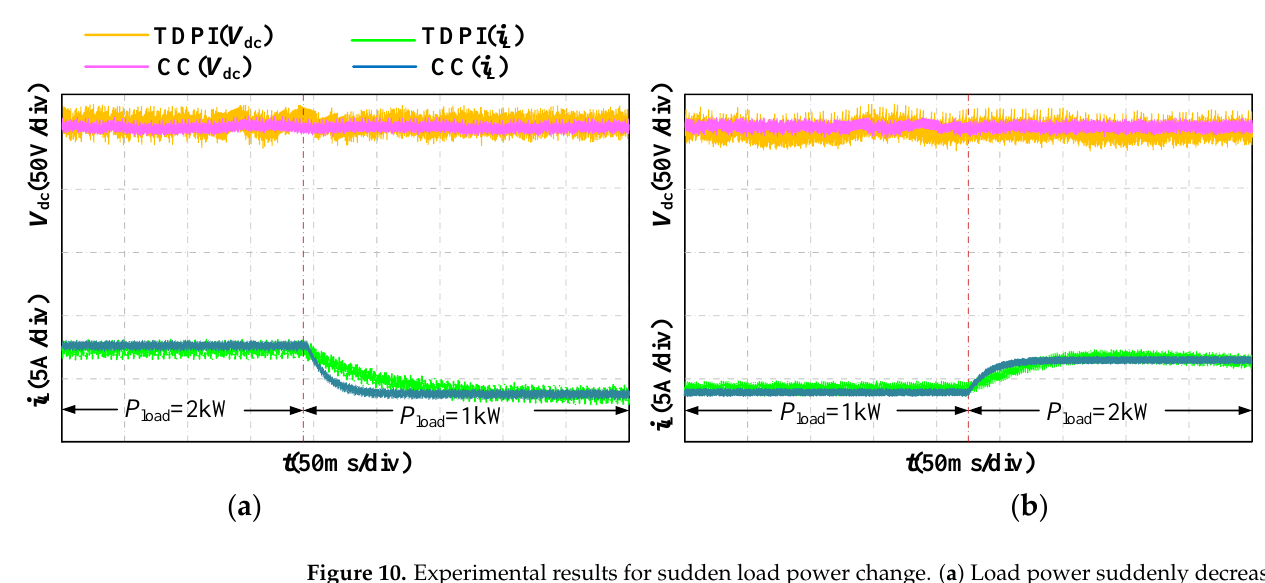
Figure 10. Experimental results for sudden load power change. ( a ) Load power suddenly decreases to 1 kW; ( b ) load power suddenly increases to 2 kW. Figure 11a,b show the comparison of the results for the battery converter output voltage V dc with the proposed CC and TDPI methods when the reference value of the battery converter output voltage V dc ref suddenly increases from 200 V to 225 V and decreases from 250 V to 210 V, respectively.